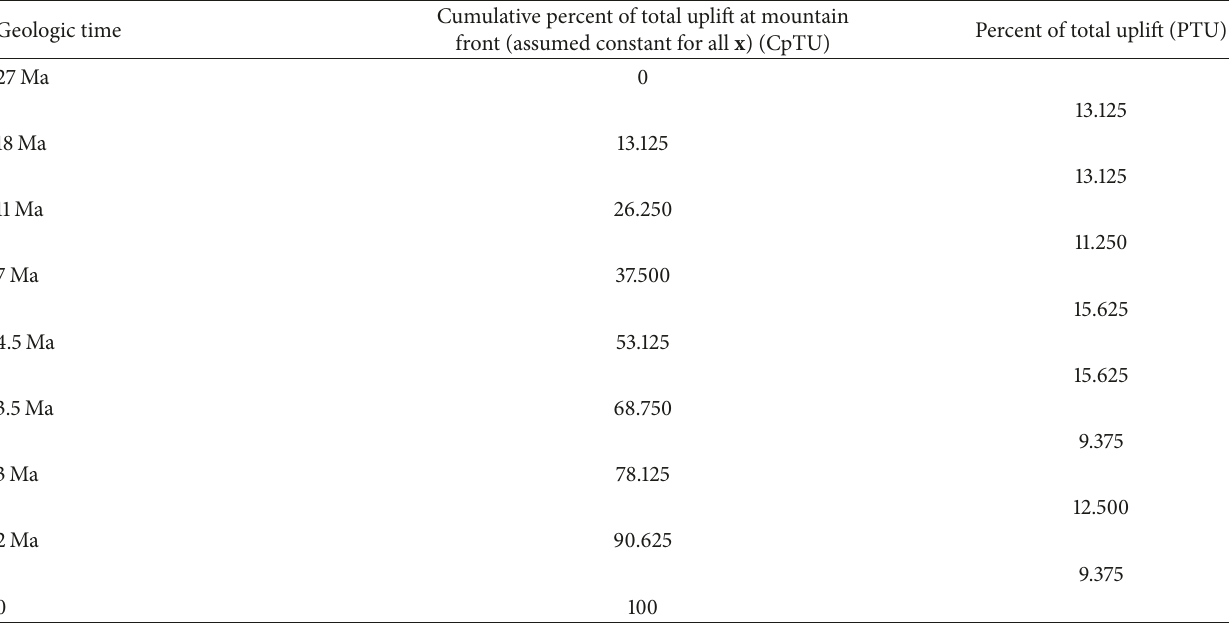
Table 4: Percent and cumulative percent of total uplift, relative to 27 Ma, for the 9 MODFLOW model times.